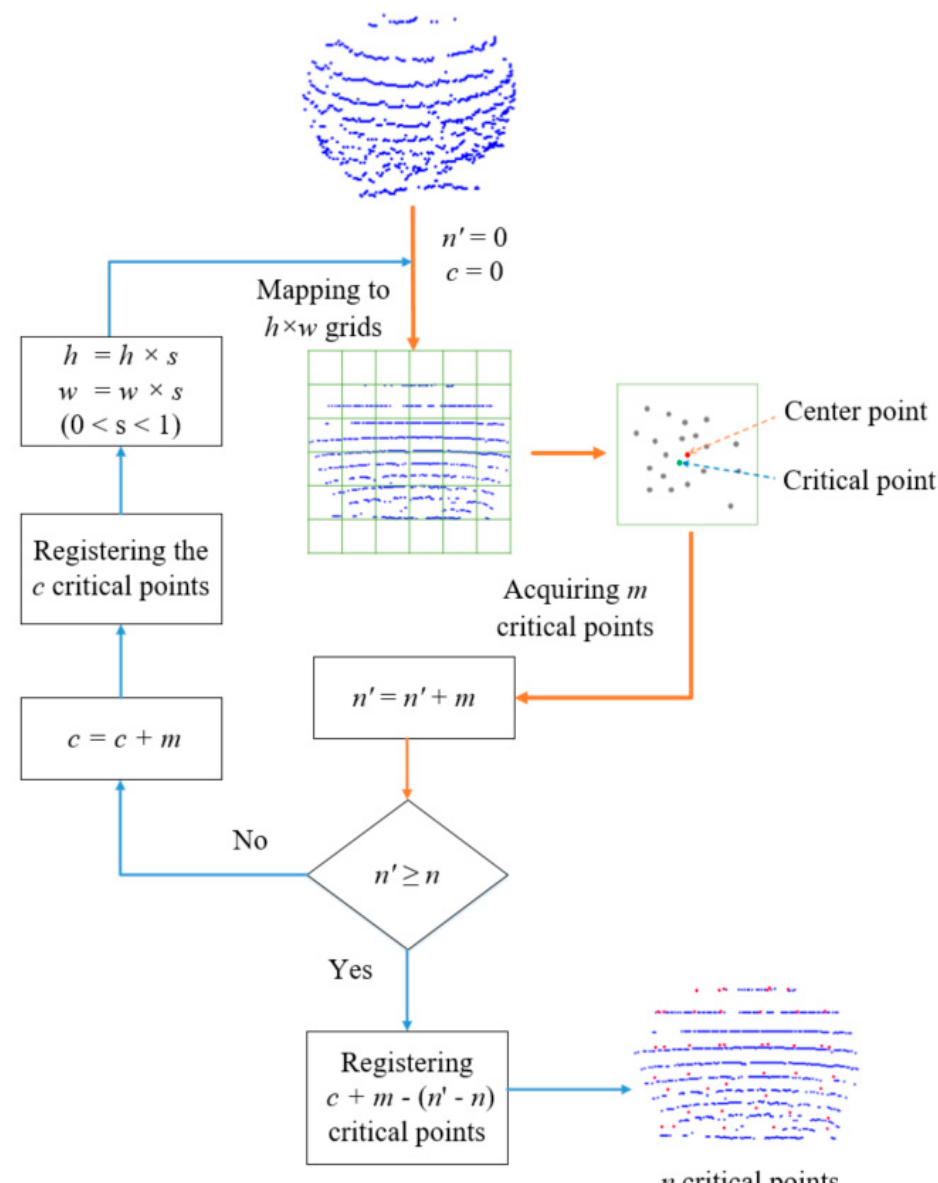
Figure 3. The process of multi-scale critical point sampling.